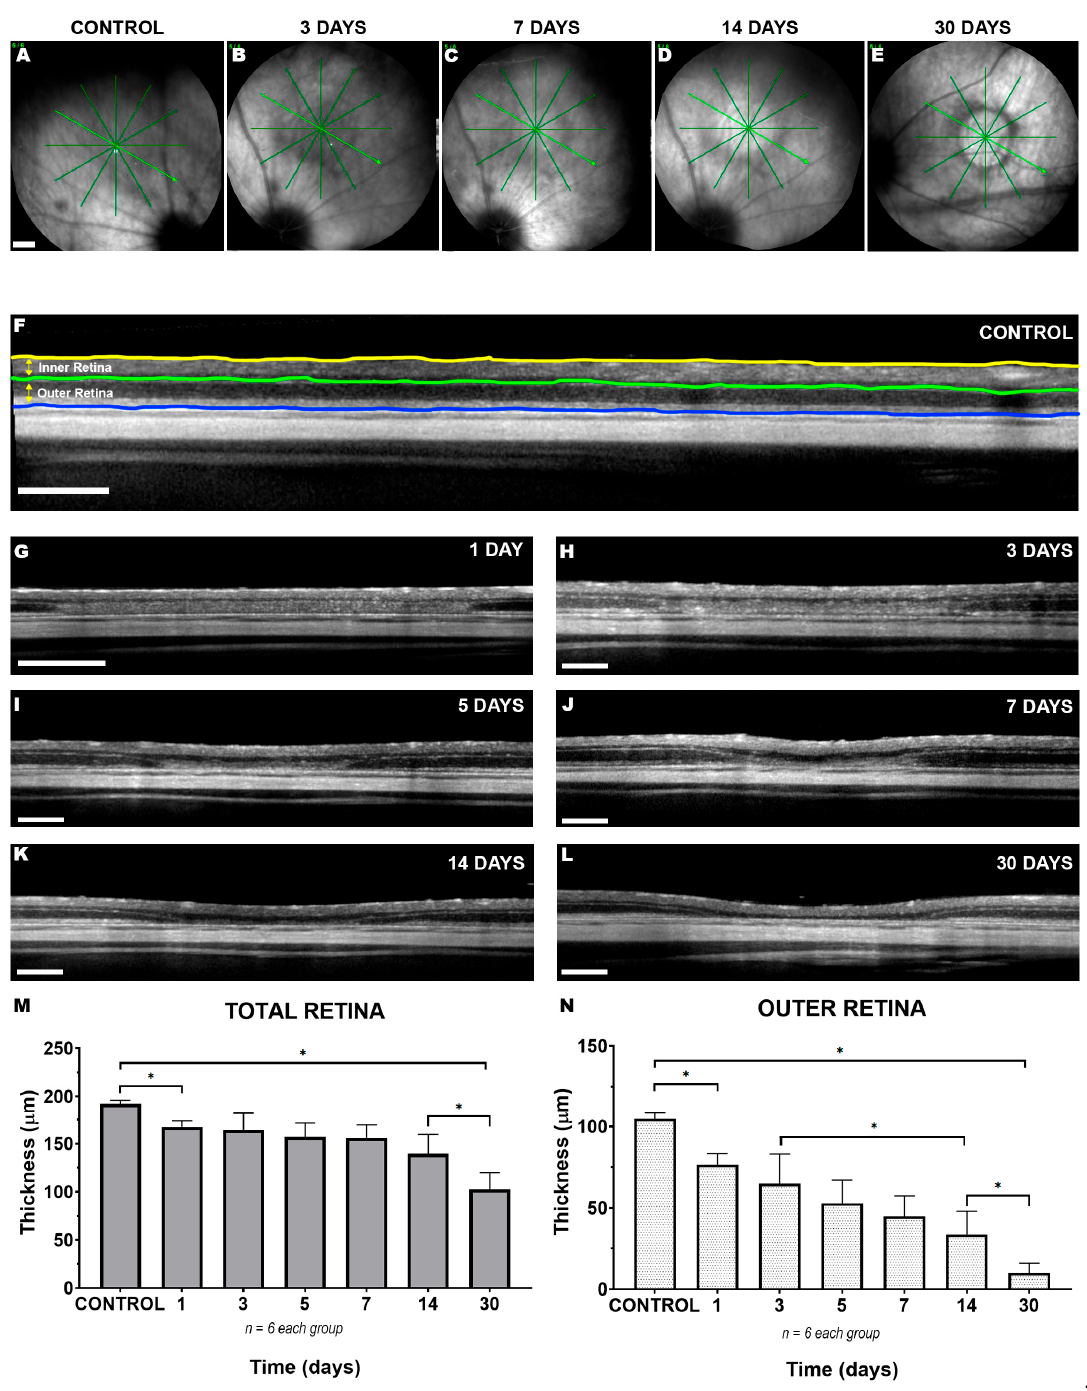
Figure 1. In vivo SD-OCT study of short- and long-term retinal thickness evolution after LIP induction. Representative eye fundus images acquired with infrared filter from a non-photoexposed control eye ( A ) and photoexposed experimental eyes at 3 ( B ), 7 ( C ), 14 ( D ), or 30 ( E ) days after LIP. For the study of total retinal thickness (from the fibre layer to the retinal pigment epithelium) and outer retinal thickness (from the outer plexiform layer to the retinal pigment epithelium) ( F ) at the centre of the lesion, it was measured using the mean of three calliper measurements provided directly by the device software. Panels ( G – L ) show representative images of lesion evolution at days 1, 3, 7, 14, and 30 after LIP. Total and outer retinal thickness measurements were analysed, and their graphical representations are shown in panels ( M , N ), respectively. n = 6 per group; * p < 0.05; (Kruskal–Wallis test).